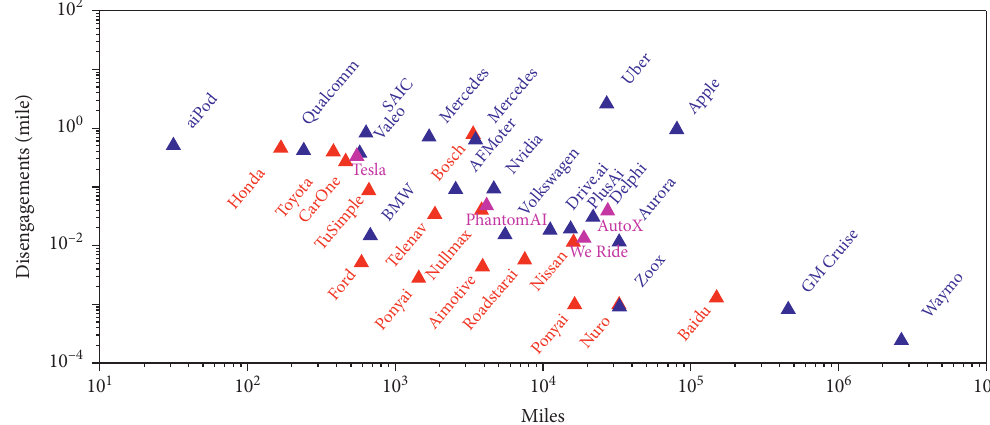
Figure 4: Number of disengagements vs. autonomous miles according to reported data from various manufacturers.